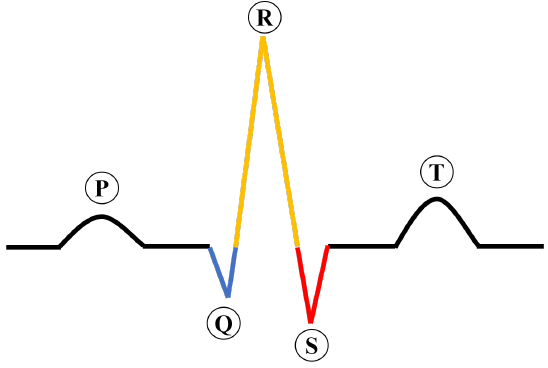
Figure 1. The construction of an ECG